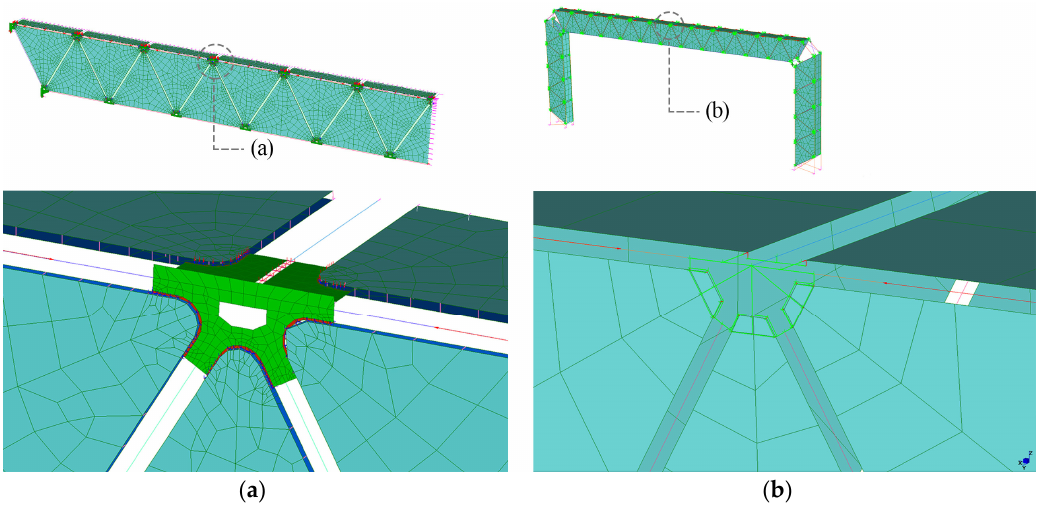
Figure 11. Details on modelling the main elements and contacts for the ( a ) BM TVT γ‐ bis and FM TVT γ‐ bis; and the ( b ) CFM TVT γ‐ bis and PM TVT γ‐ bis